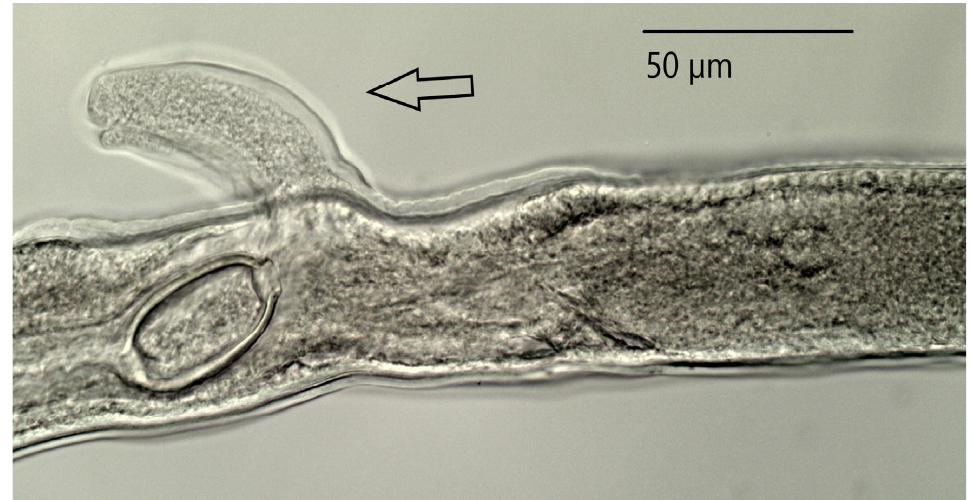
Figure 2. Vulvar area in female Capillaria phasianina. The arrow indicates the tubular appendage.